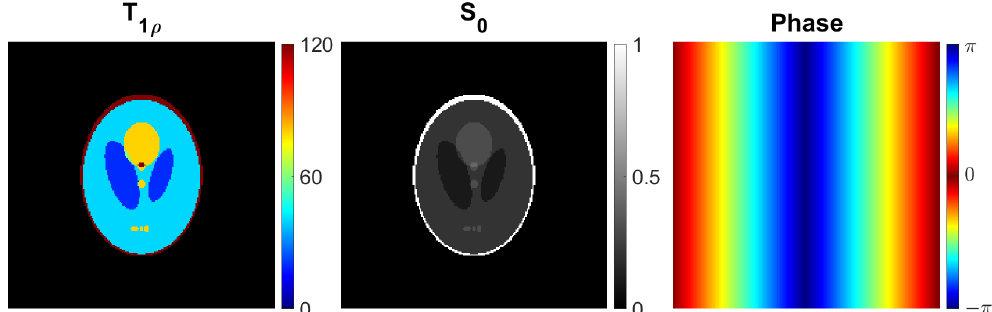
Figure 2. The simulated T 1 ρ , S 0 , and phase parameter maps for the radial golden angle T 1 ρ phantom